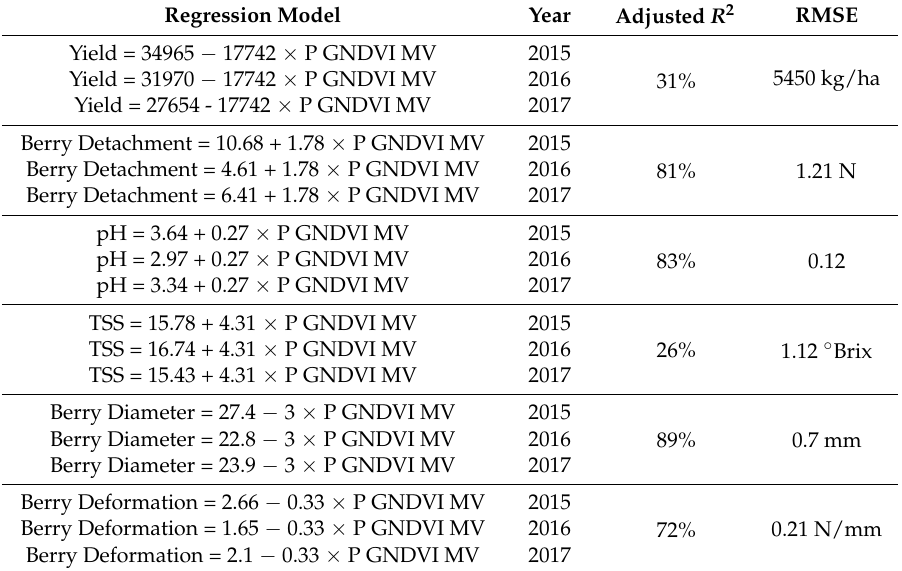
Table 9. Regression model of correlated crop parameters with proximal-derived GRVI at the middle of veraison crop stage.